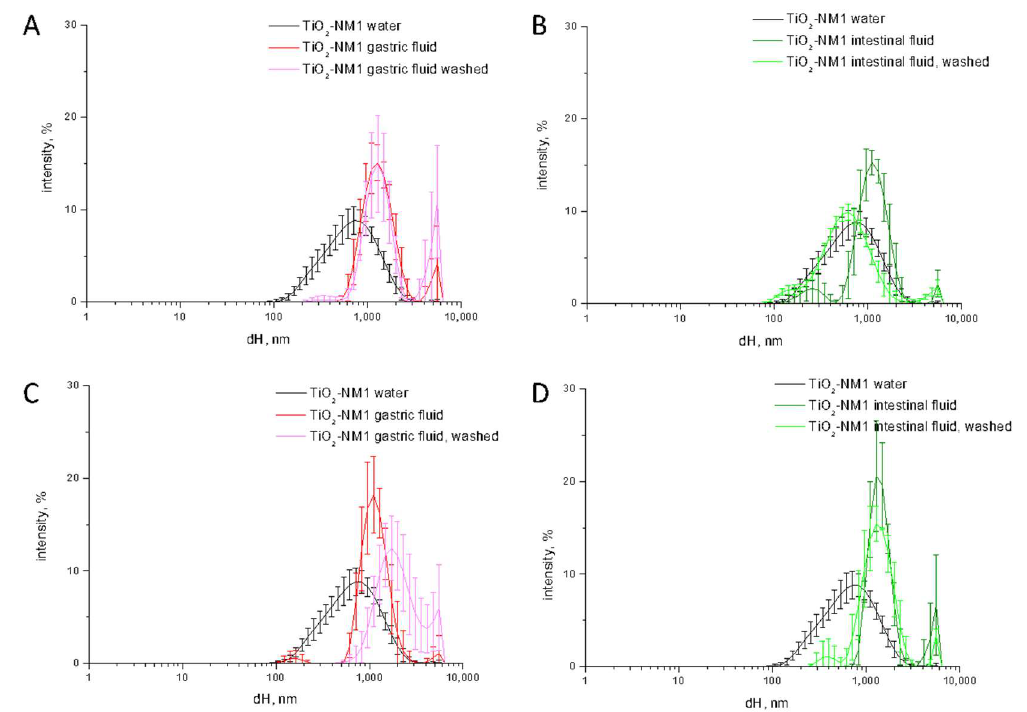
Figure 4. Size distribution monitored by dynamic light scattering (DLS) of TiO 2 -NM1 incubated in the single simulated fluids ( A , B ) or after the digestion cascade ( C , D ). The measurements were performed on the treated sample and on the sample treated and washed with water. The hydrodynamic diameters (d H ) distribution (% intensity) is expressed as mean value of 5 measurements in three independent experiments ± SD.